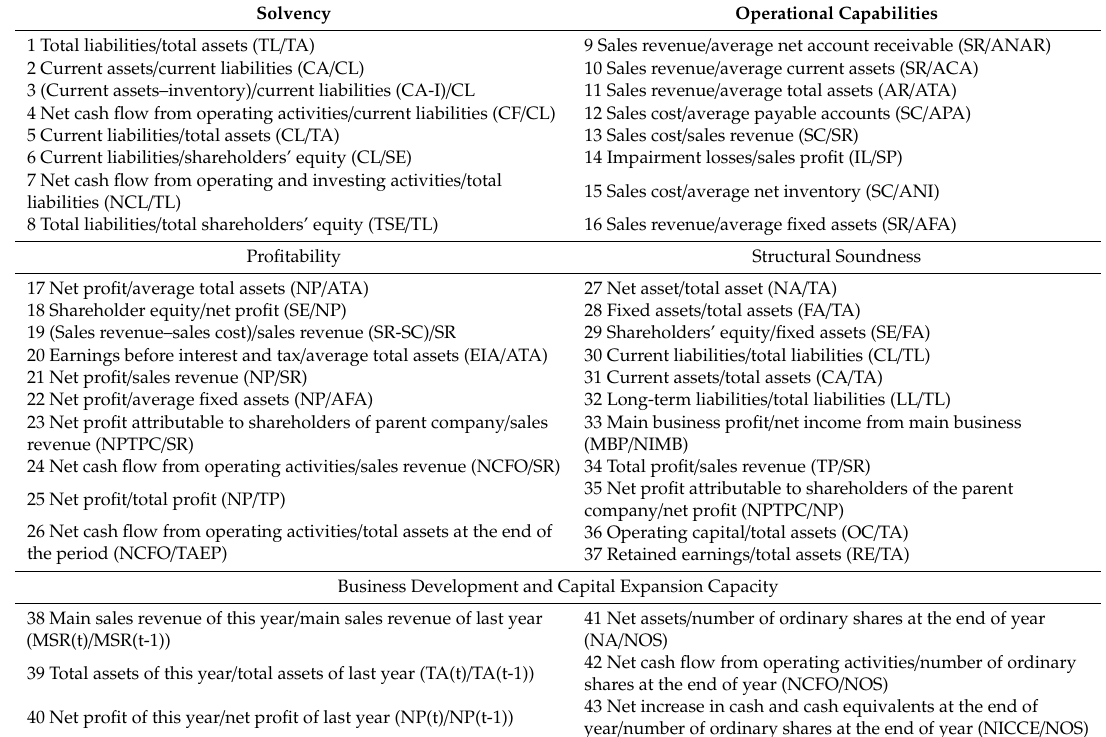
Table 1. List of financial